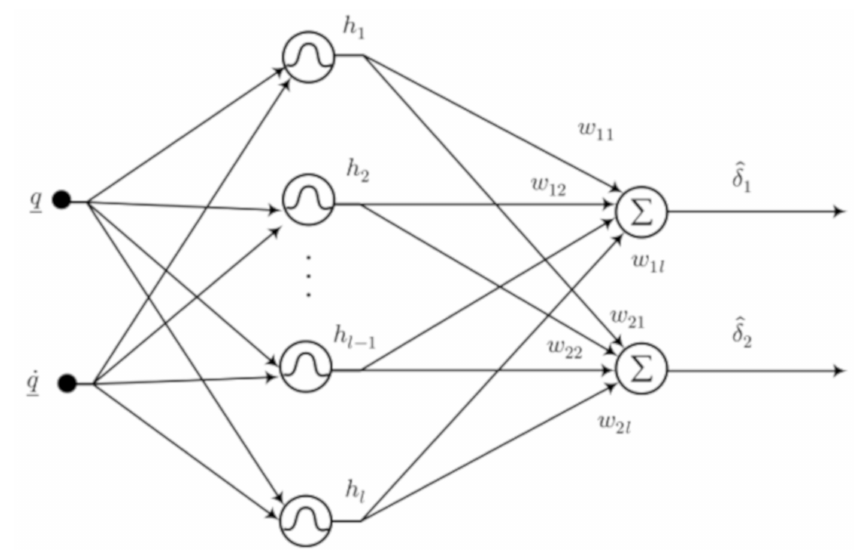
Figure 2. A radial basis function neural